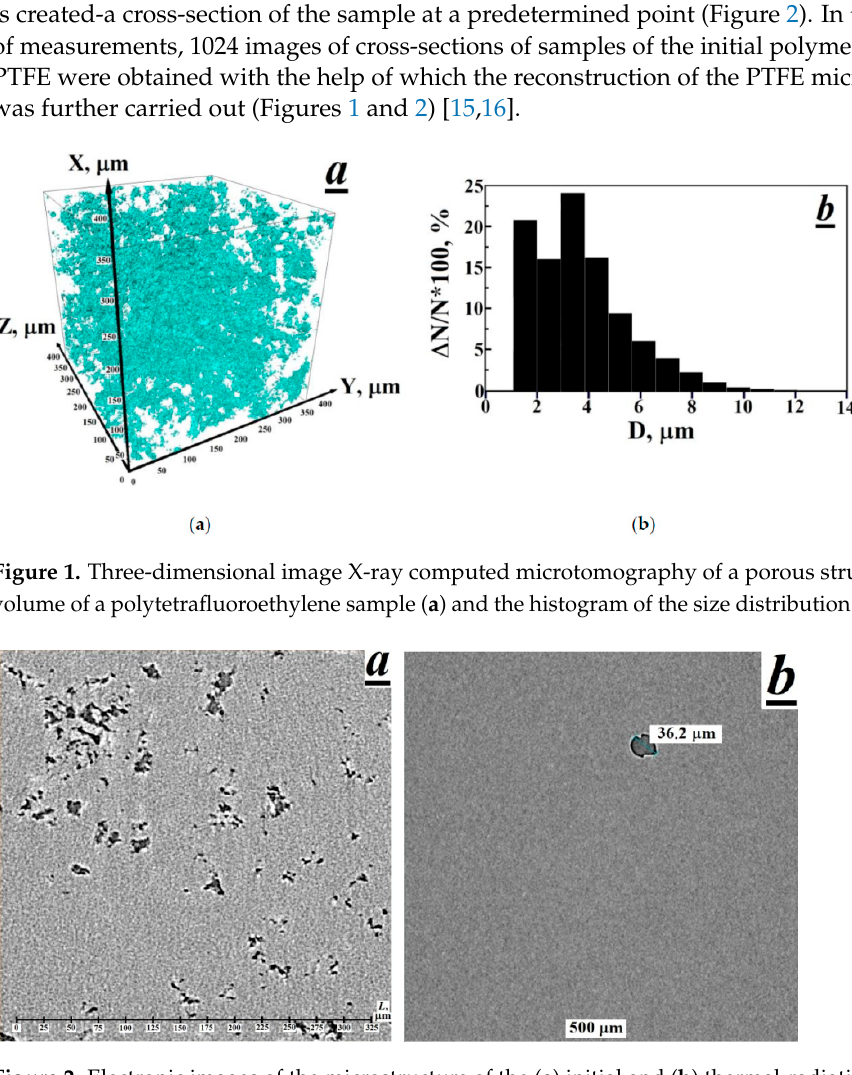
Figure 2. Electronic images of the microstructure of the ( a ) initial and ( b ) thermal-radiation-modified polytetrafluoroethylene samples, recorded by X-ray computed microtomography by scanning the samples at the half of the height of the sample.